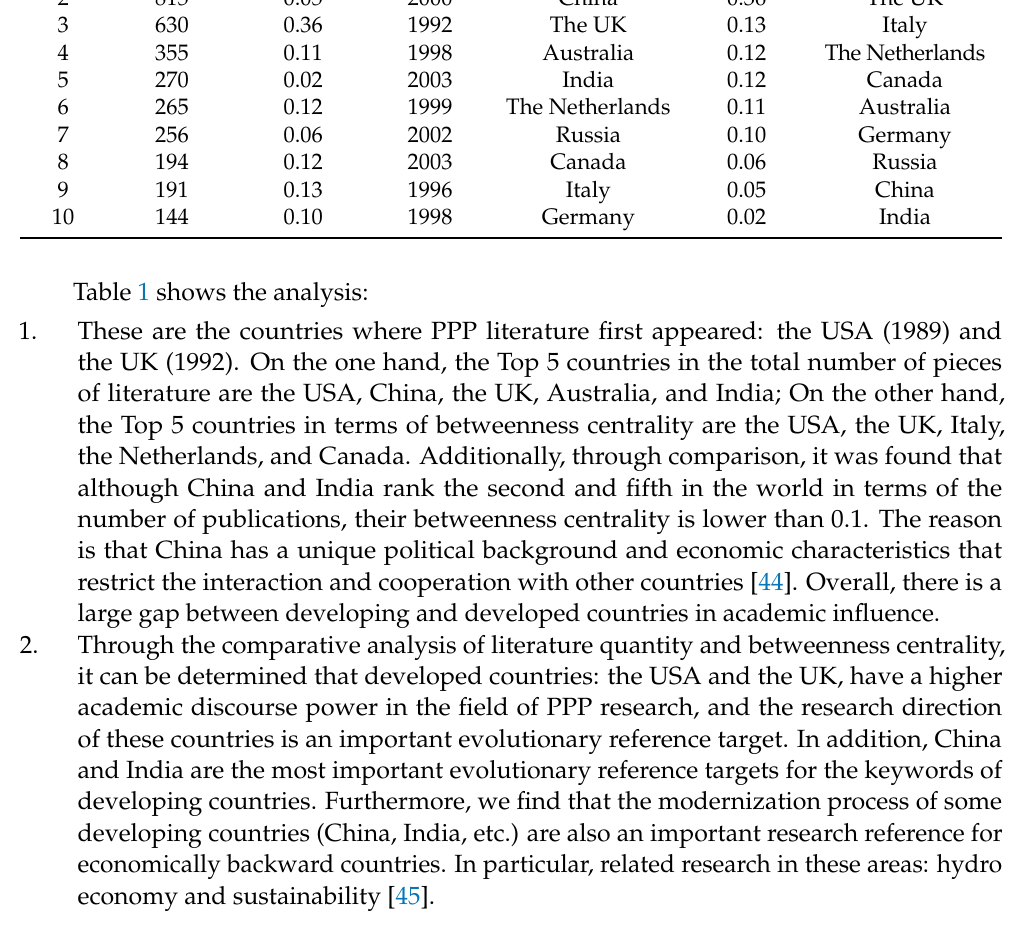
Comparison of Betweenness